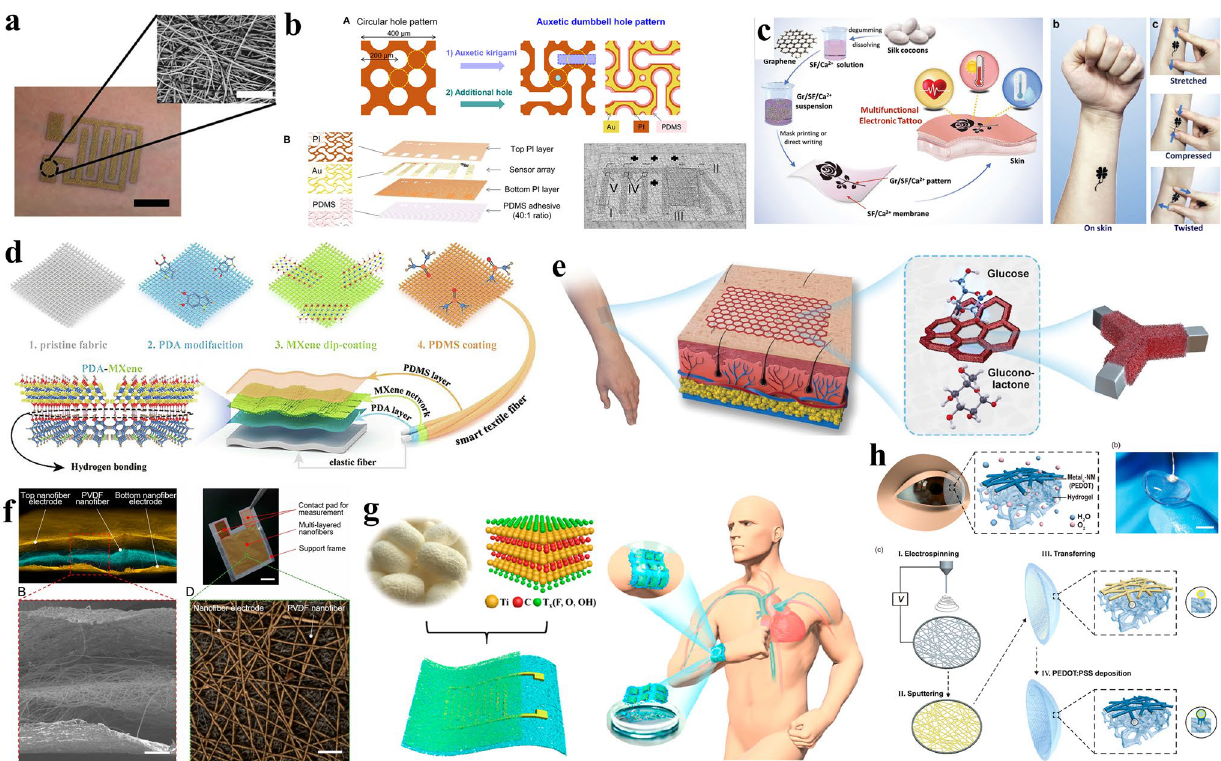
Fig. 4 a Photograph and SEM image of the nanomesh‑based humidity sensor. Reproduced with permission from Ref. [69]. Copyright 2020 Wiley. b Structure of the breathable e‑skin inspired by the sweat pore. Reproduced with permission from Ref. [70]. Copyright 2021 AAAS. c The fabrication process of the self‑healable electronic tattoos. Reproduced with permission from Ref. [74]. Copyright 2021 Wiley. d Preparation process of the superhydrophobic textile‑based e‑skin. Reproduced with permission from Ref. [75]. Copyright 2021 Elsevier. e The breathable and self‑supporting glucose sensor. Reproduced with permission from Ref. [76]. Copyright 2021 Wiley. f The structure of the all‑nanofiber‑ based cardiac sound sensor. Reproduced with permission from Ref. [77]. Copyright 2020 PANS. g Schematic illustration of the silk‑MXene human voice detector. Reproduced with permission from Ref. [78]. Copyright 2021 American Chemical Society. h The structure of the breath‑ able contact lens. Reproduced with permission from Ref. [79]. Copyright 2019 American Chemical